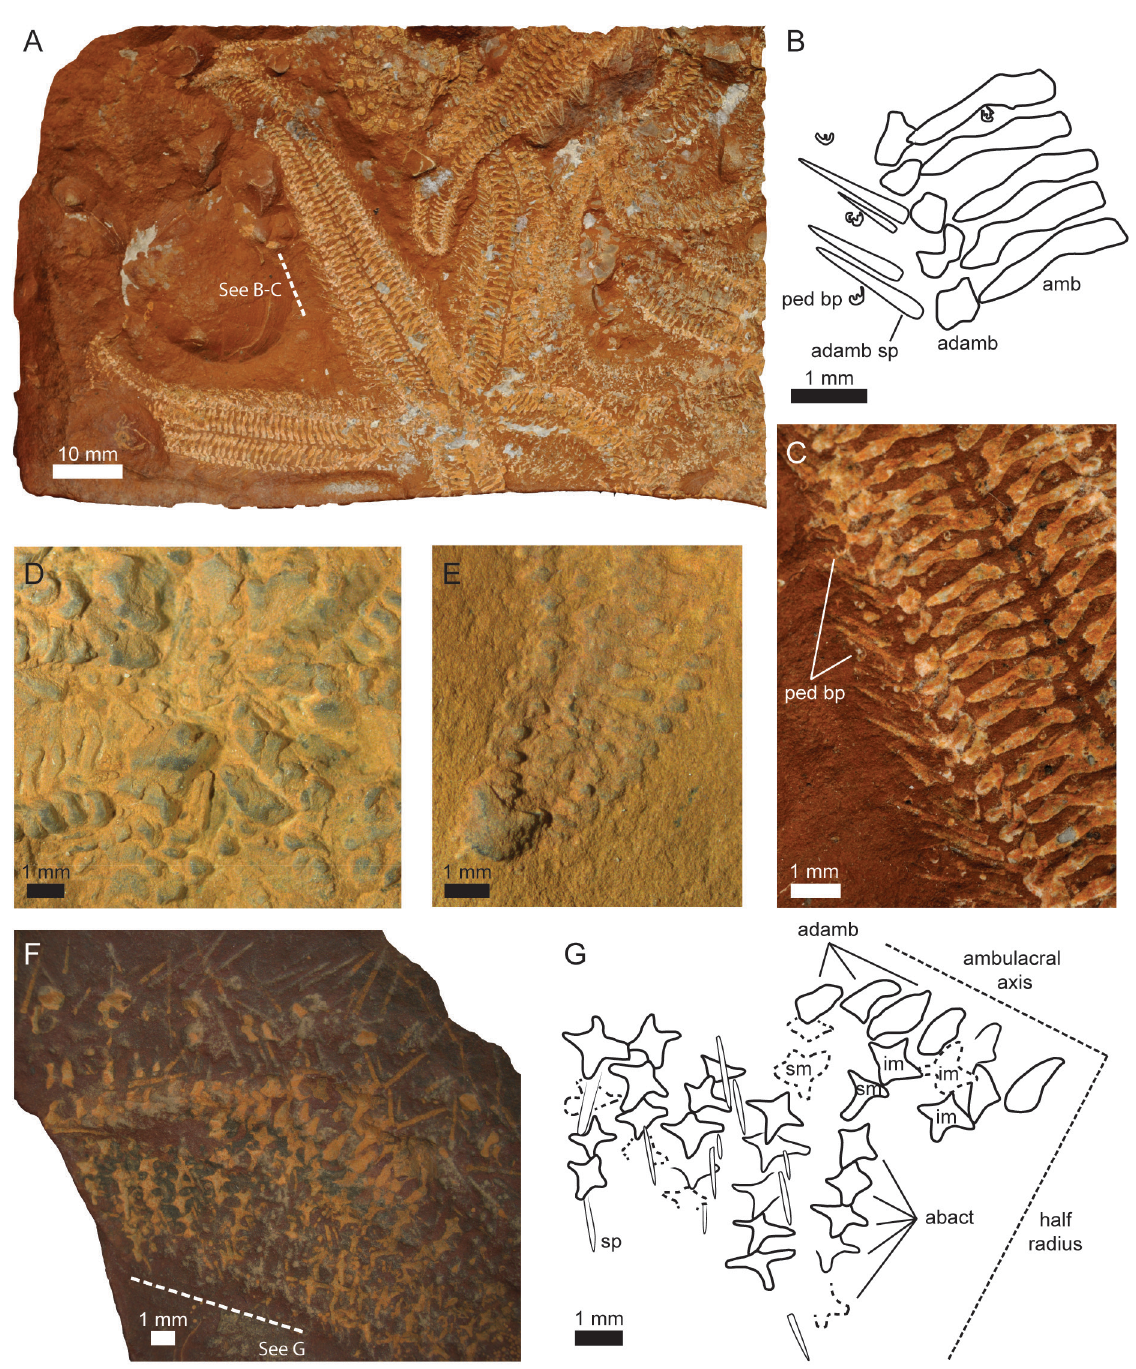
Fig. 2. Polarasterias janusensis Rousseau & Gale gen. et sp. nov. A–C . Holotype PMO 218.011a. A . Nearly complete specimen preserved in a cut-through fashion. B . Drawing detail from ambulacral groove showing ambulacrals, adambulacrals, adambulacral spines and scattered valves of forcipulate pedicellariae. C . Portion of arm illustrated in B, basal pieces of straight pedicellariae visible in cross section. D . Paratype PMO 217.982, oral region in actinal view. E . Paratype PMO 217.936, Arm tip showing terminal ossicle. F–G . Paratype PMO 218.069. F . Obliquely compressed radius showing adambulacrals, marginals, and columns of abactinal ossicles. G . Drawing detail from F. Abbreviations: abact = abactinal ossicle; adamb sp = adambulacral spine; adamb = adambulacral; amb = ambulacral; im = inferomarginal; ped bp = basal piece of pedicellariae; sm = superomarginal; sp